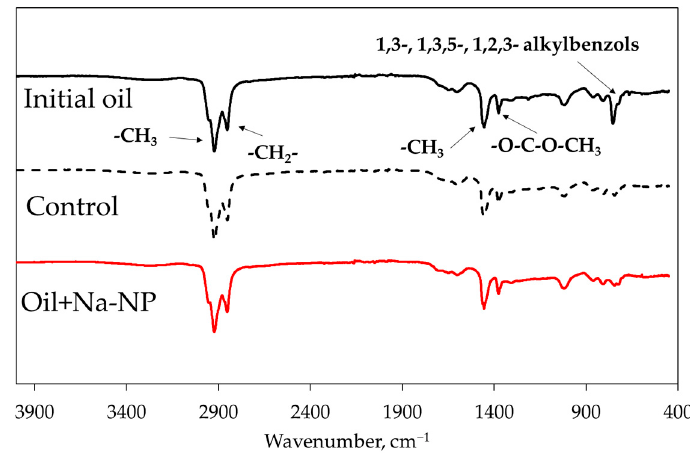
Figure 5. IR spectra of resins before and after processing.